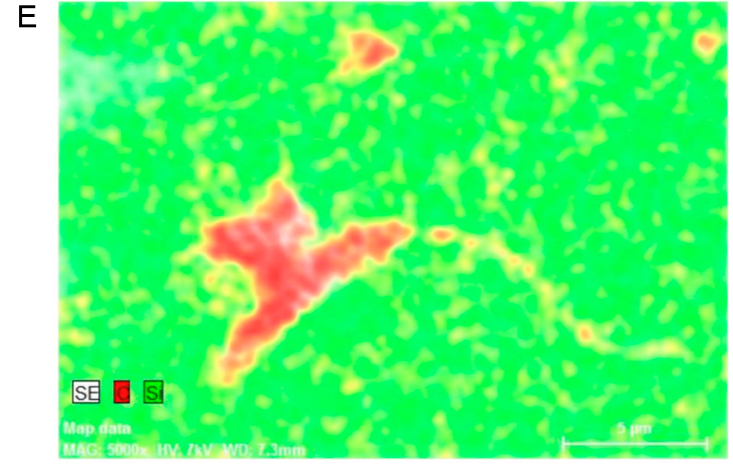
Figure 6. Organic contents of L. amazonensis promastigotes treated with L1. SEM images were analyzed by X-ray spectroscopy. The diagram shows the results of Spectroscopy of Scattered Energy (SSE) analysis ( A ); graphical representation of the content in the SEM image ( B ); carbon (( C ), red); silicon (( D ), green) map of the cellular content; and merging ( E ) of the results.